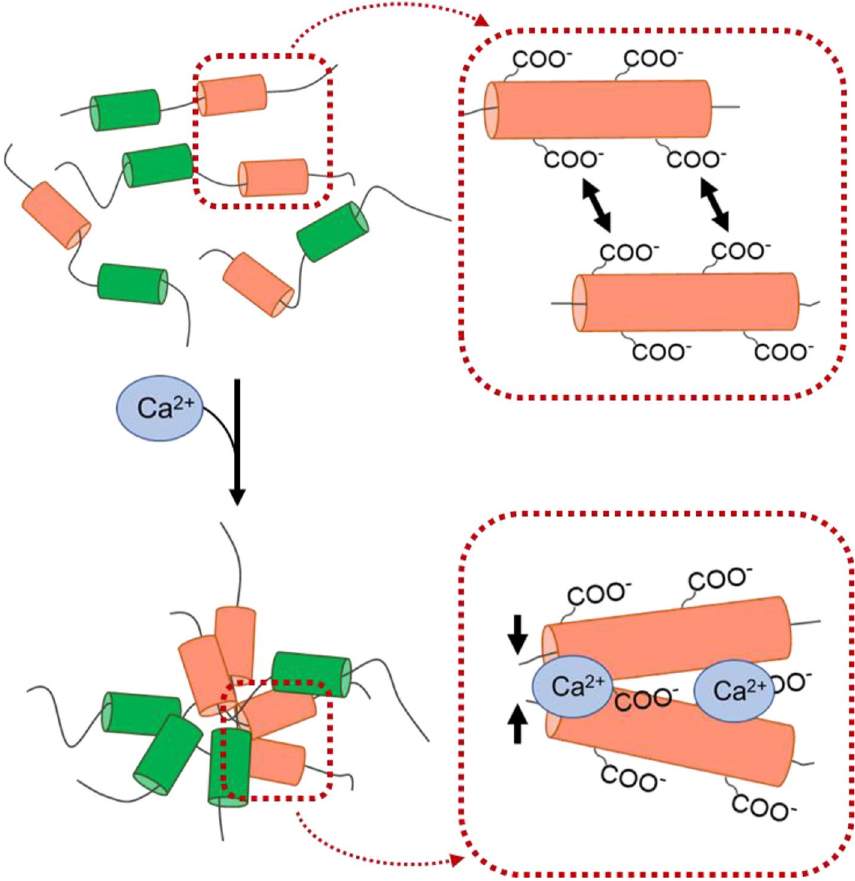
Figure 6. A schematic illustration for the proteins aggregation with calcium ion. Without calcium ion, proteins including acidic amino acid-rich region (pink) are dispersed to some extent because of an electrical repulsion between carboxy groups of acidic amino acids. When calcium ion comes, the cation of calcium ion disturbs the electrical repulsion, leading to the aggregation. After aggregation, the cross-linkage may occur by methionine- rich regions